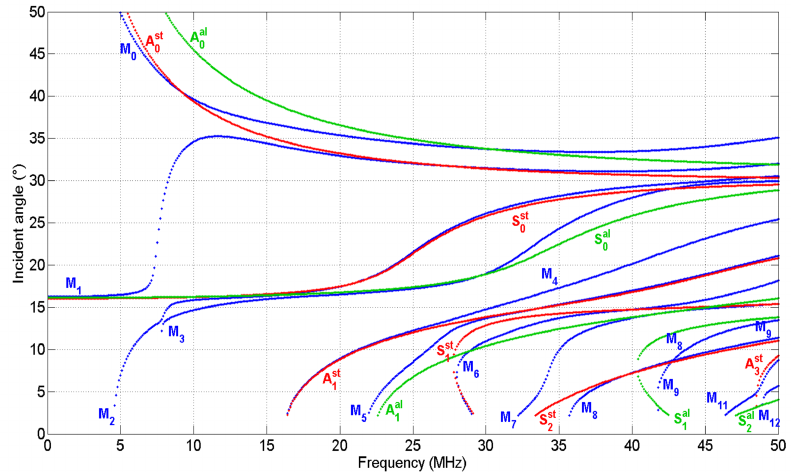
Figure 4. Superimposition of the dispersion curves of the three-layer structure (blue color) with the Lamb wave curves of the aluminum layer (green color) and steel layer (red color), considered